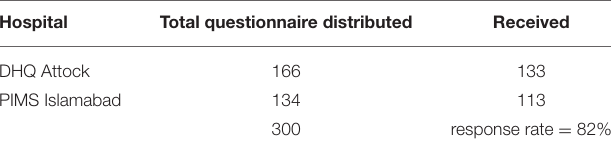
TABLE 1 | Distribution and collection of questionnaire.